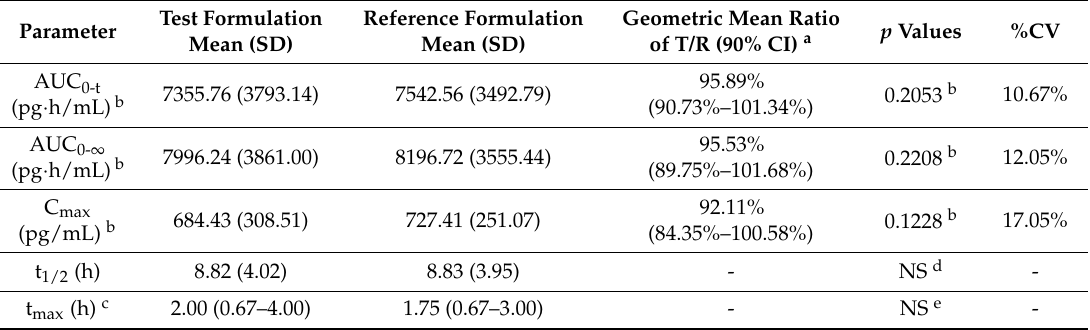
Figure 1. The mean plasma concentration–time profiles of pramipexole in 22 subjects after a single dose oral administration of 0.25 mg pramipexole tablets produced by PT Dexa Medica and the reference drug, Sifrol ® , produced by Boehringer Ingelheim Pharma GmbH & Co. KG. Table 3. Pharmacokinetic parameters and bioequivalence evaluation of pramipexole in 22 subjects after a single-dose oral administration of 0.25 mg pramipexole tablets of both test (T) and reference (R) formulations.